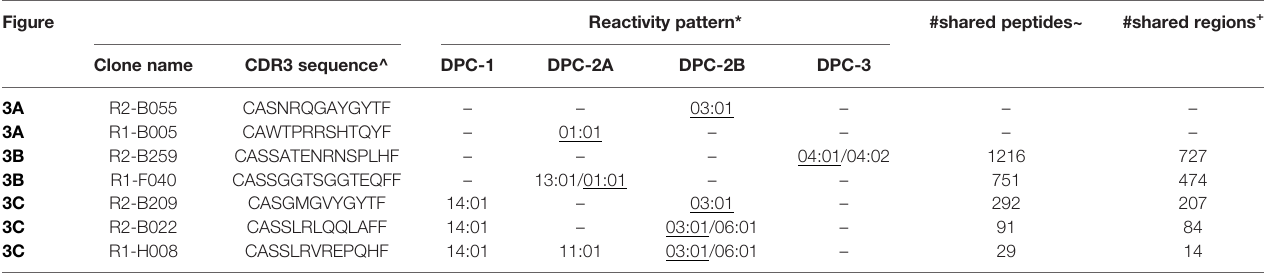
*The reactivity against different HLA-DP molecules, with the target HLA-DP molecules underlined. ^The clonality of the T-cell clones was analyzed by sequencing the complementarity-determining region-3 (CDR3) of the TCR b chains. ~The shared peptide sequences of the recognized HLA-DP molecules. + The shared region sequences of the recognized HLA-DP molecules.